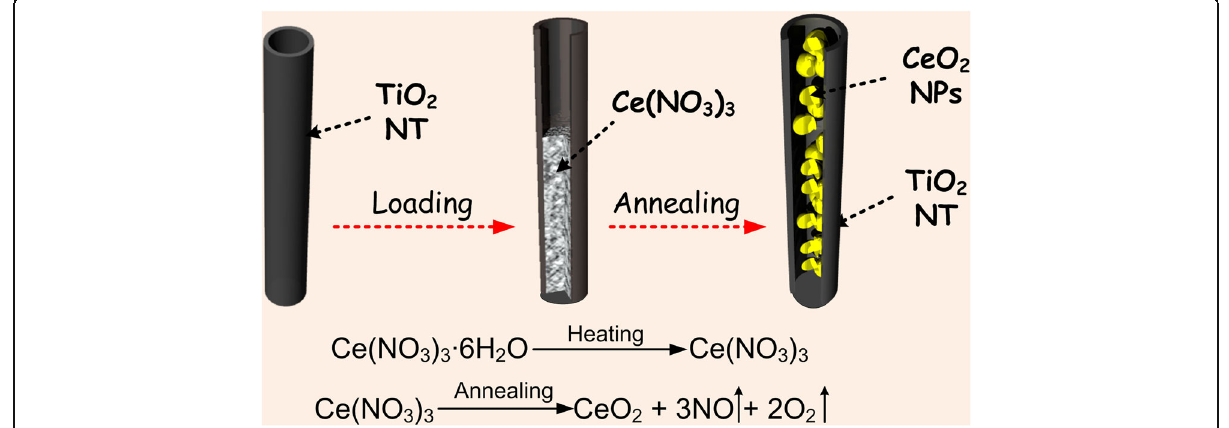
Fig. 8 Schematic synthesis diagram of the CeO 2 /TiO 2 heterojunctions and involved chemical